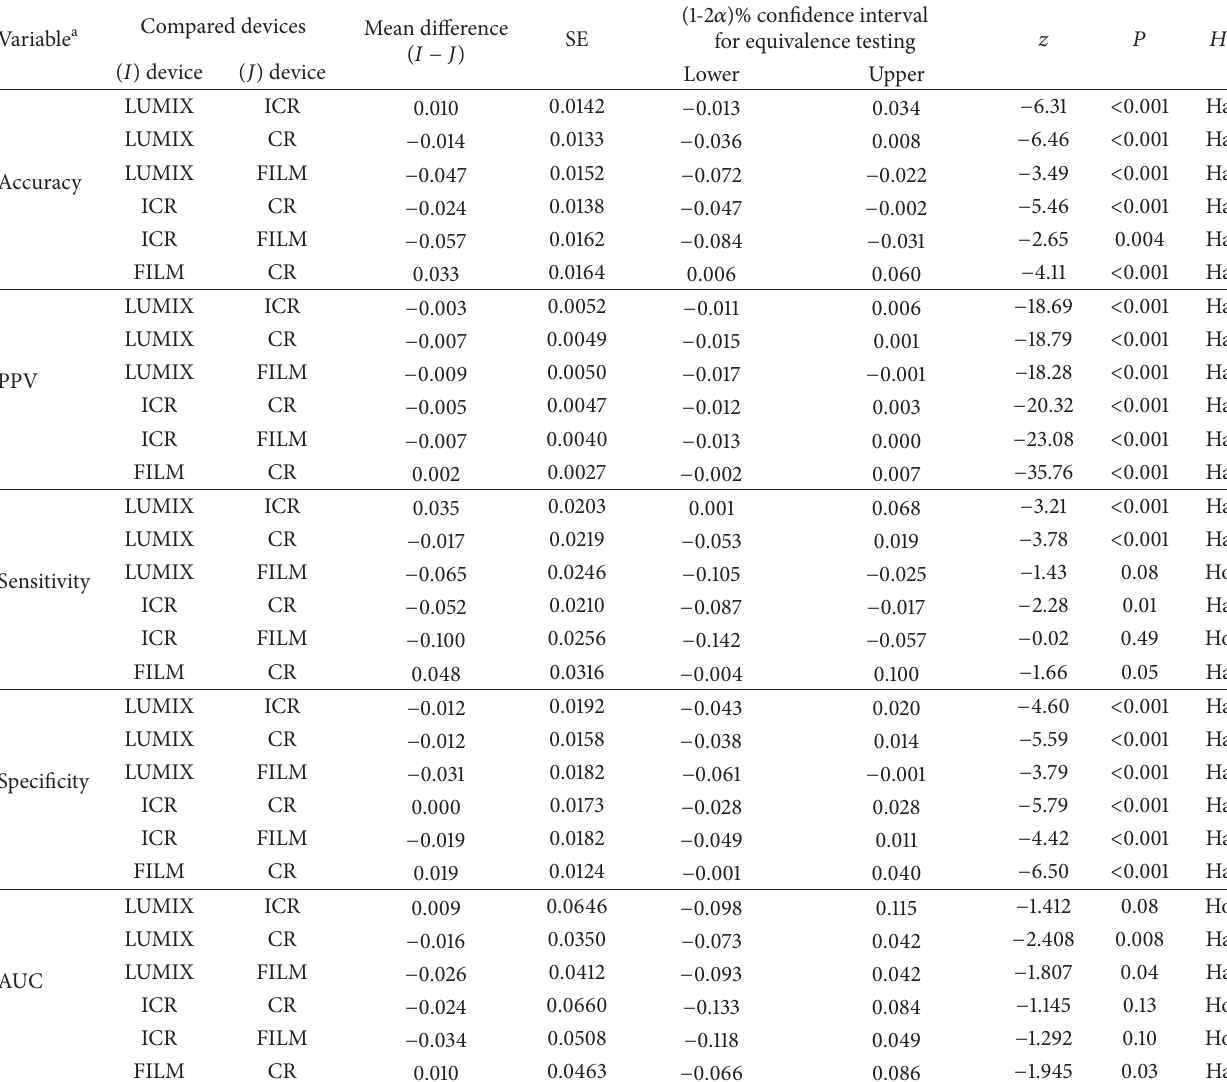
Table 6: Equivalence tests for accuracy, PPV, sensitivity, specificity, and AUC by paired devices ( 𝛿 = 0.1 ). Variable